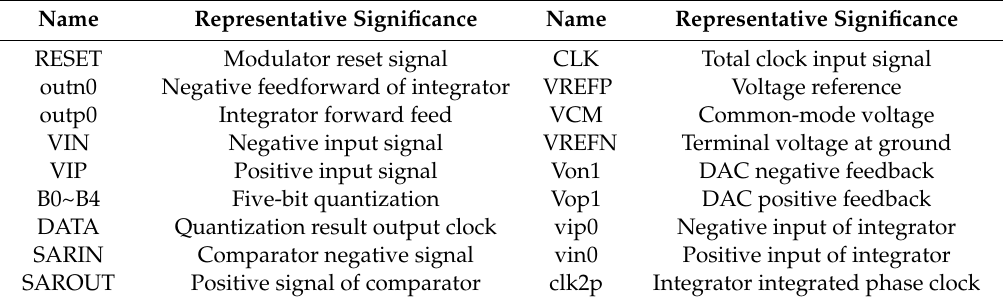
Table 1. Description table of the modulator structure diagram.